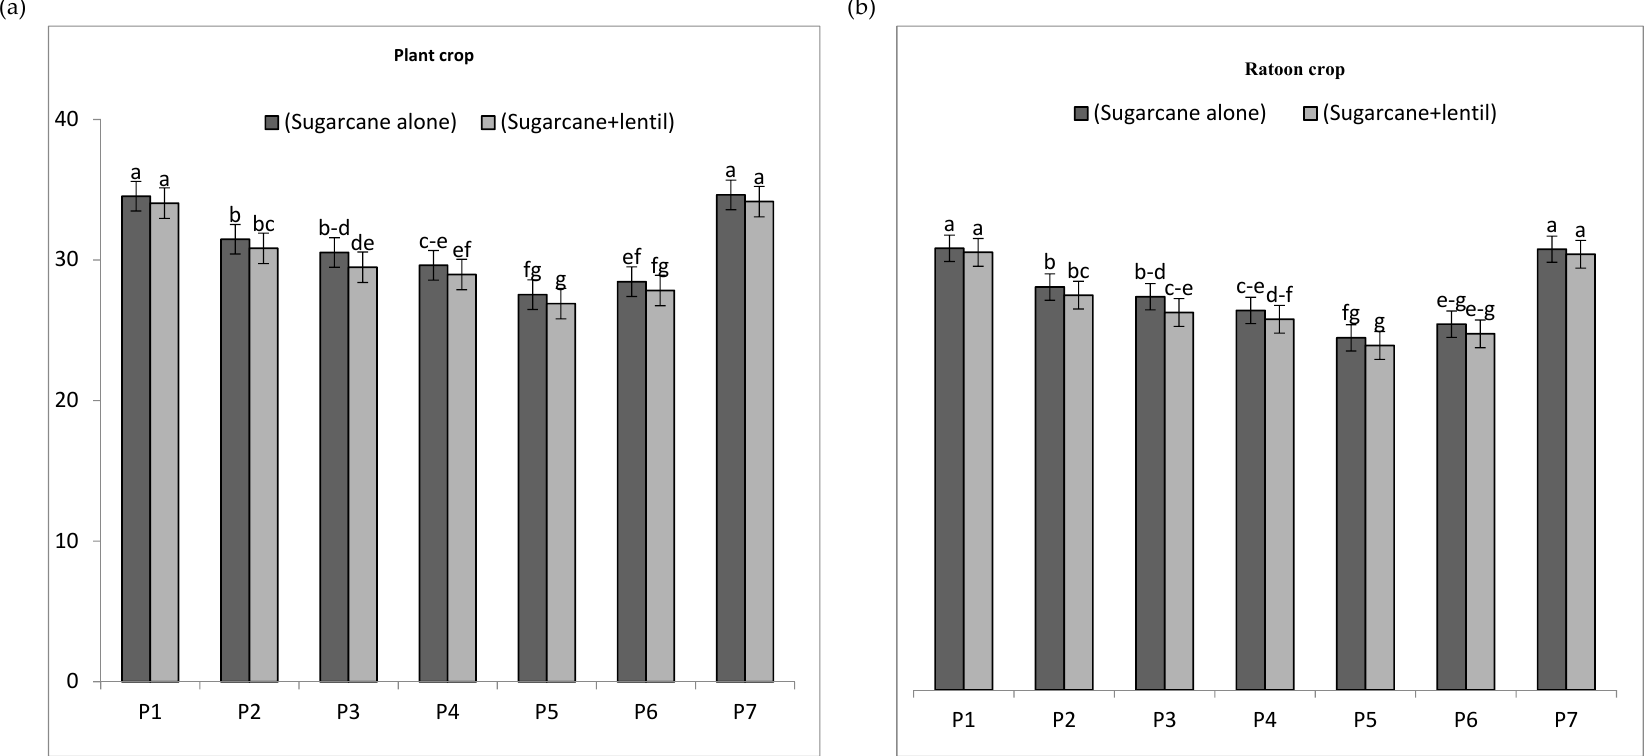
Figure 7. Total dry matter (t/ha) of sugarcane as influenced by various planting patterns and lentil intercropping in (a) Plant crop and (b) ratoon crop. P 1 : 45 cm pits with 90 cm diameter, P 2 : 60 cm pits with 90 cm diameter, P 3 : 75 cm pits with 90 cm diameter, P 4 : 90 cm pits with 90 cm diameter, P 5 : 60 cm single rows planting, P 6 : 90 cm double rows planting, P 7 : Trench planting at 120 cm. Any two means not sharing a common letter(s) differ significantly at 5% probability.